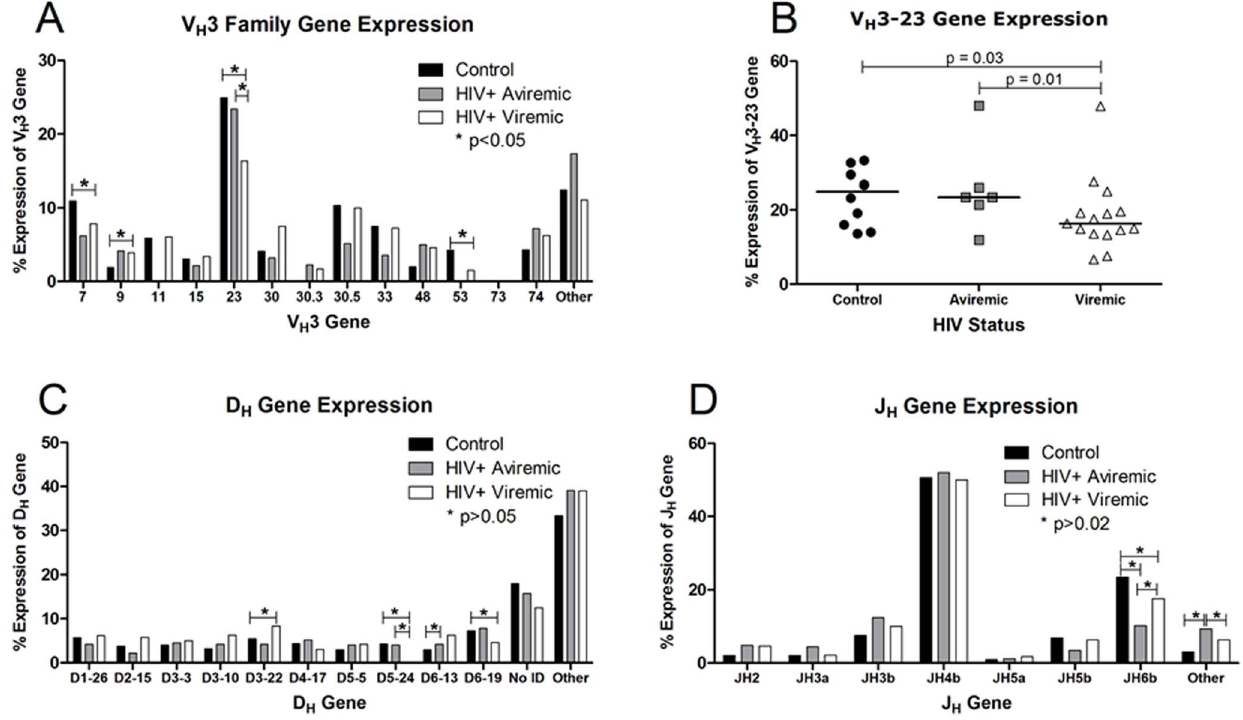
Figure 1. Expression of V H 3, D, and J family genes. Data are shown as group medians among HIV-1-seronegative control subjects (n=10; black bars or circles), aviremic patients (n=6; gray bars or squares), and viremic HIV-1-infected patients with detectable plasma HIV-1 RNA (n=15; white bars or triangles). Values were calculated from individual mean percent expression for each gene. A) V H 3 family gene expression. ‘‘Other’’ includes V H 3-13, -20, -43, -49, -64, -65, -66, -72, and unidentified genes which ranged from 0.4% to 12.6% expression. P values were calculated by Mann- Whitney test. Significant p values were found for V H 3-7 (p=0.05), V H 3-9 (p=0.05), V H 3-23 (p=0.03), and V H 3-53 (p=0.007). B) V H 3-23 expression. Each point represents the mean percentage of V H 3-23/total V H 3 genes for each patient. The solid bar indicates the group median. C) D gene expression was calculated as with V H 3 gene expression. ‘‘Other’’ includes D1-1, D1-7, D1-14, D1-20, D2-2, D2-8, D2-21, D3, D3-9, D3-16, D4, D4-b, D4-11, D4-23, D5-12, D6-6, and D6-25 which ranged from 0.4% to 4.3% expression. ‘‘No ID’’ (12.5–18.0% of sequences) indicates that gene identification could not be assigned. P values were calculated by Mann-Whitney test. Significant overall p values were found for D3-22 (p=0.04), D5-24 (p=0.05), and D6-19 (p=0.04). D) J gene percent expression was calculated as described above. ‘‘Other’’ includes JH1, JH4a, JH4d, JH6a, and JH6c which ranged from 0.2% to 6.7% expression. Statistics were also calculated as above. A significant overall p value was found for JH6b